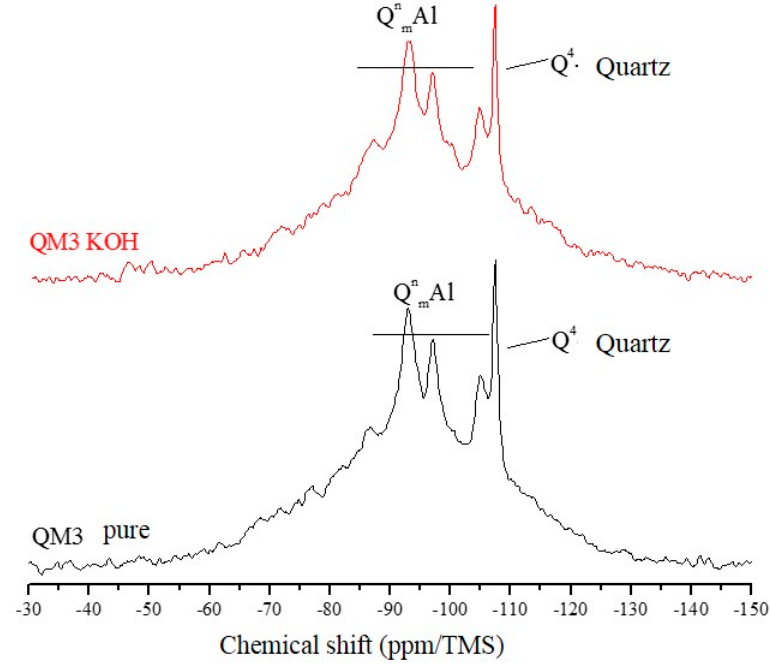
Figure 8. Spectra obtained by NMR using direct polarization of 29 Si, of the QM2 sample.